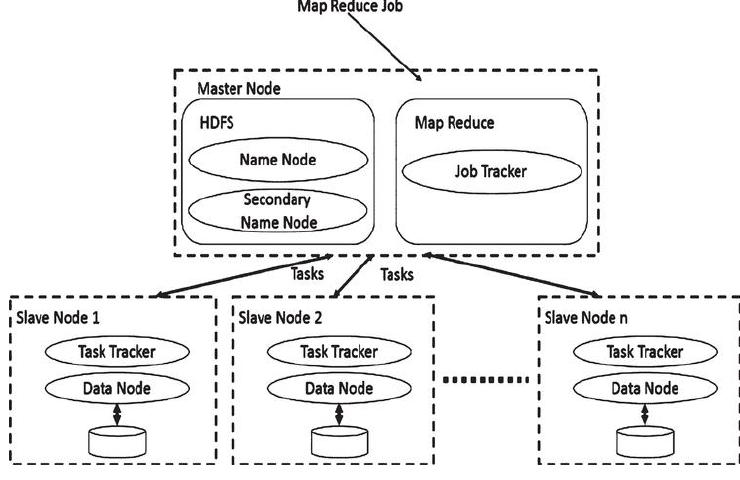
Figure 5. System architectures of MapReduce and HDFS